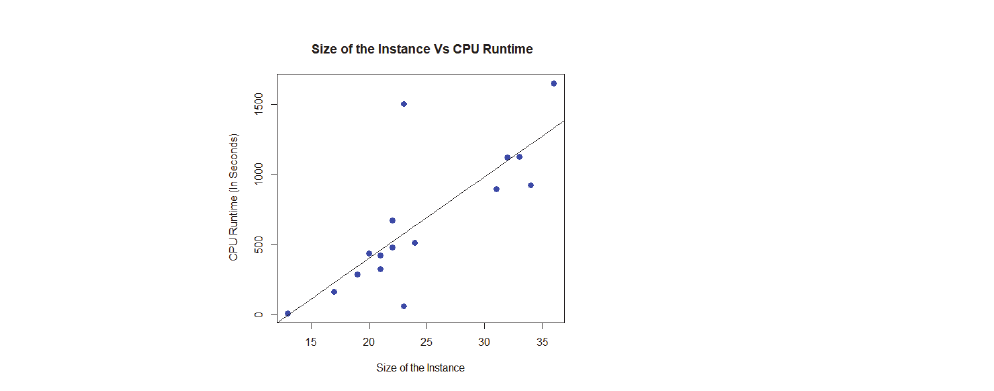
Fig. 6. Scatter plot with correlation